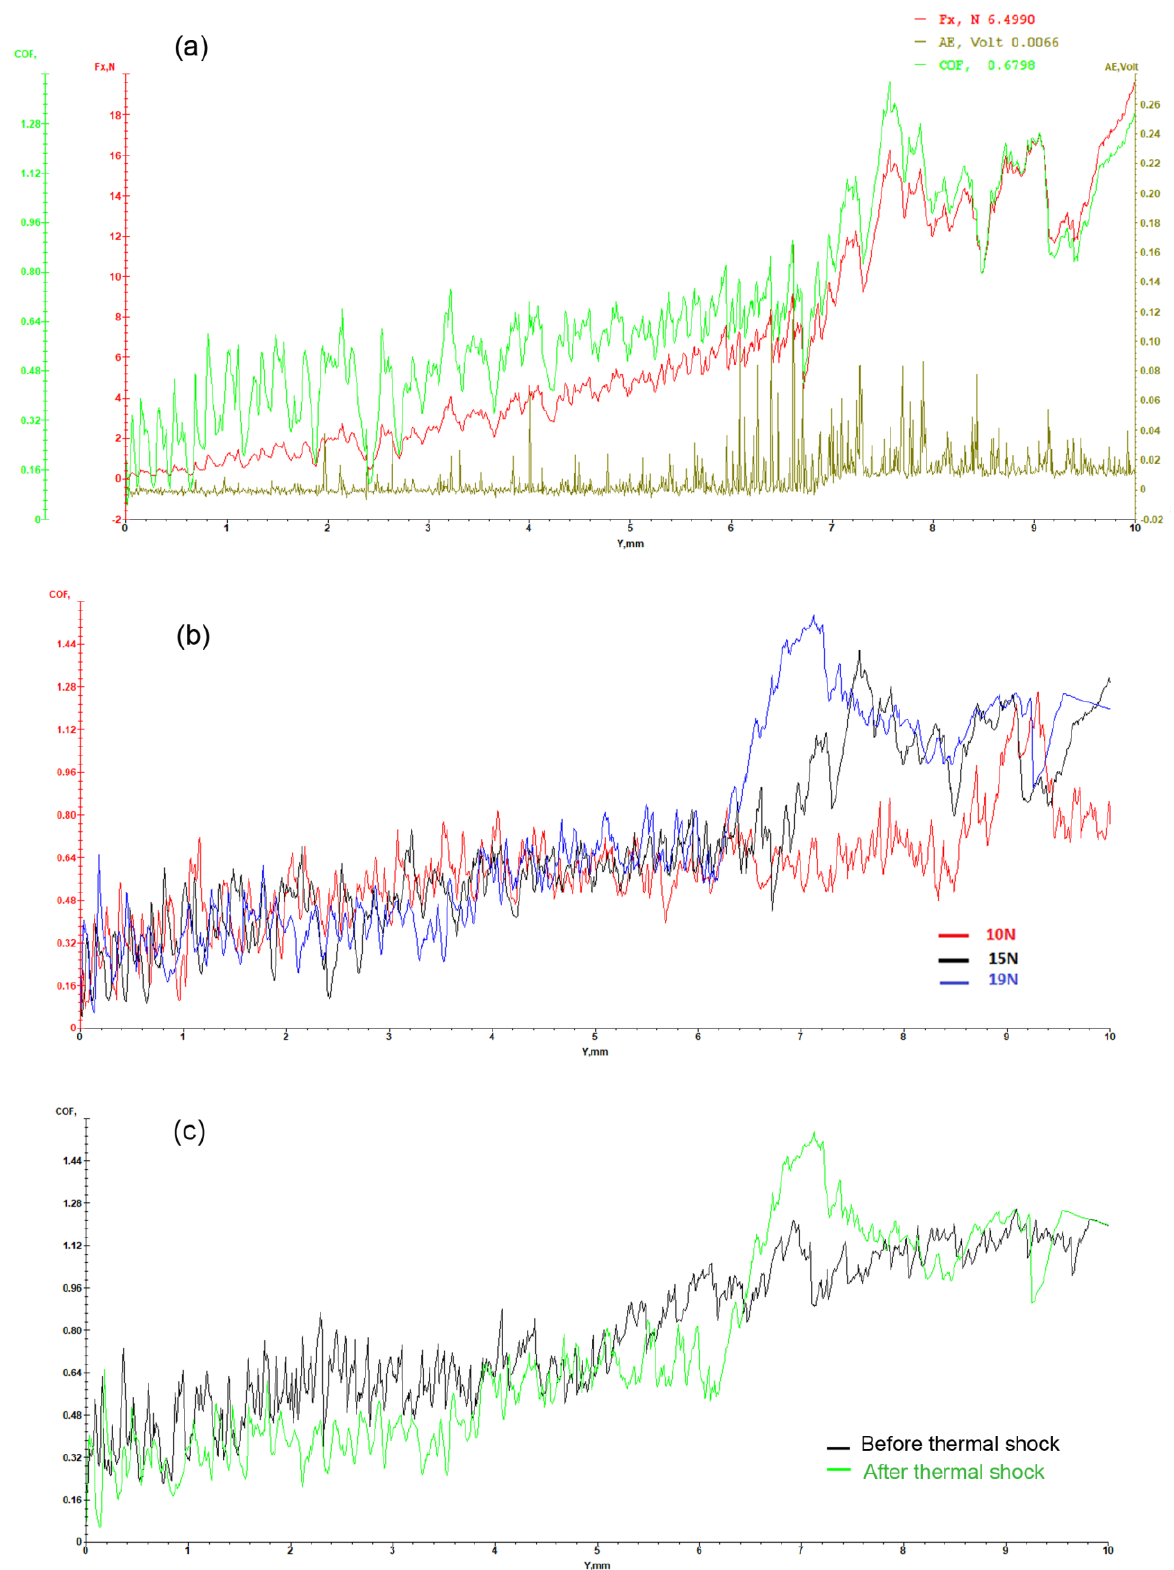
Figure 10. Fx, COF and AE evolution on the ceramic layer in ( a ), friction coefficient for different forces in ( b ) and comparison of the COF behavior between ceramic layer before and after thermal shocks in ( c ).